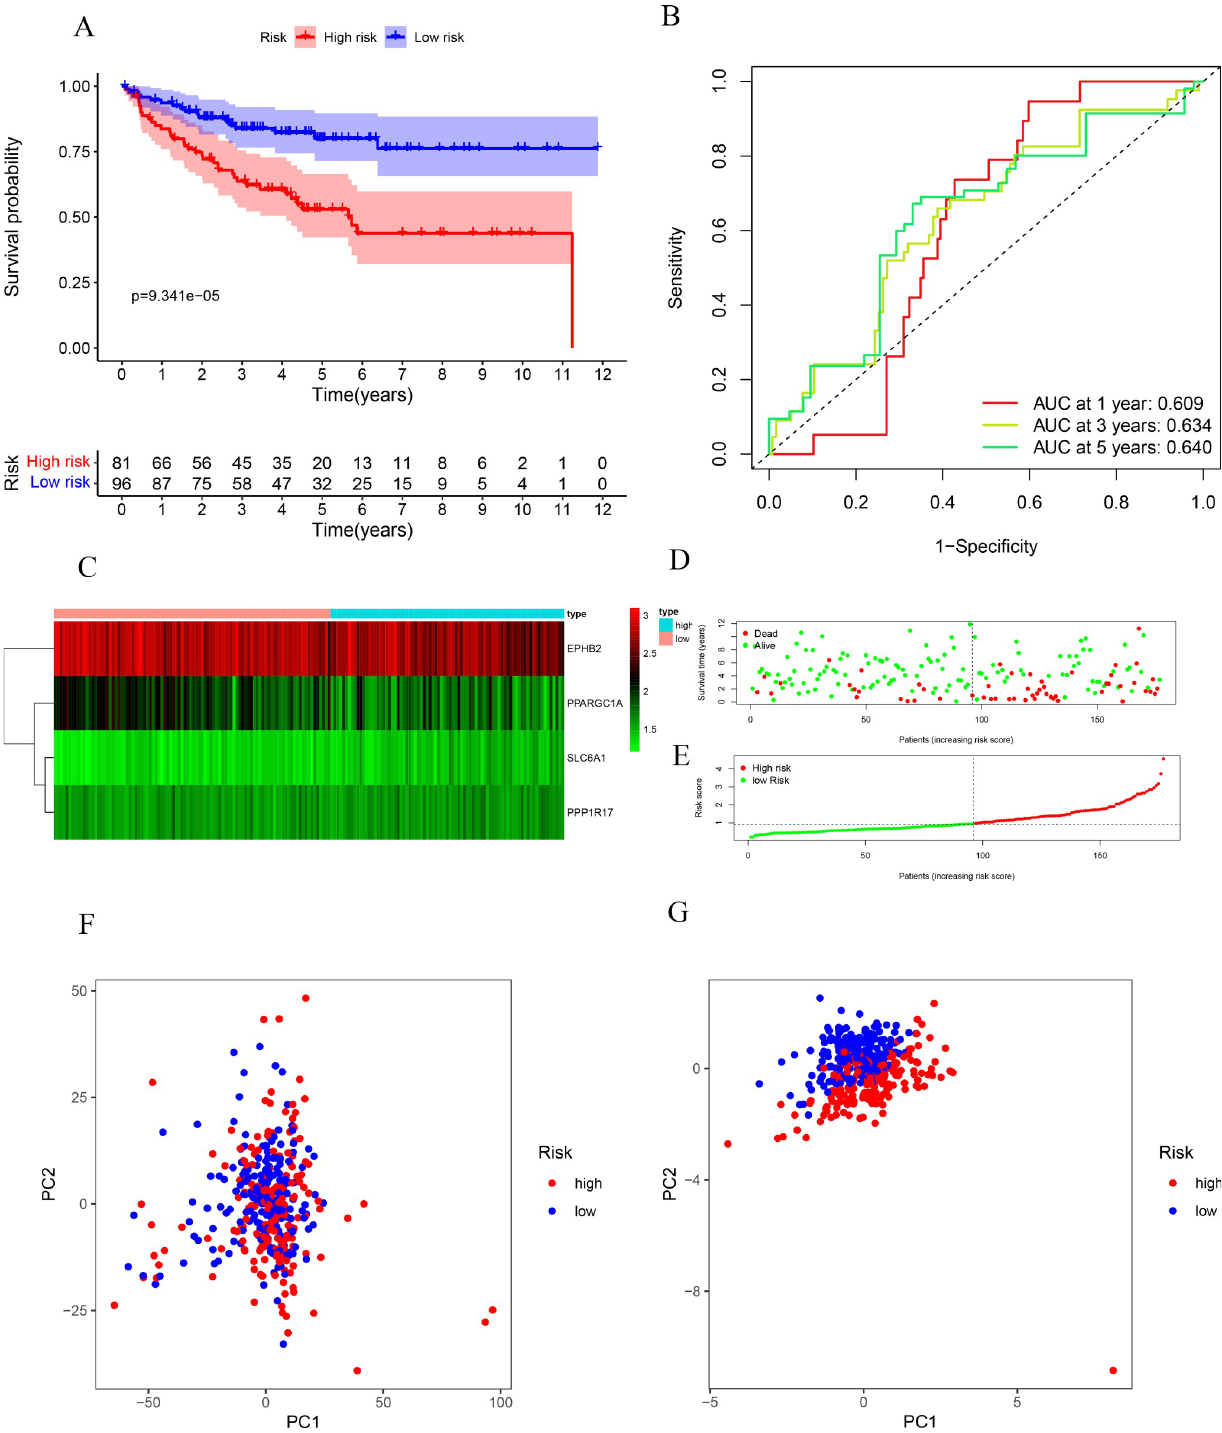
Fig 6. Risk score analysis of the four-gene prognostic model in the GEO cohort. (A) Survival curve for low-risk and high-risk groups. (B) ROC curves for prediction of overall survival (OS) based on the risk score. (C,D,E) Expression heat map, risk score distribution, and survival status.PCA analysis of MRGs (F) and model genes